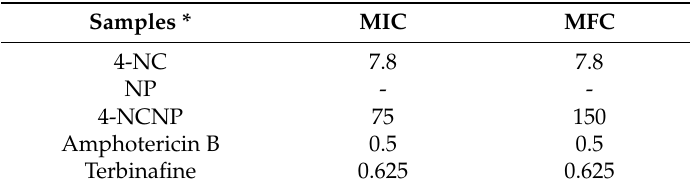
Table 2. Minimal inhibitory concentration (MIC) and minimal fungicide concentration (MFC) of 4-NC, nanoparticles, and controls ( µ g / mL).